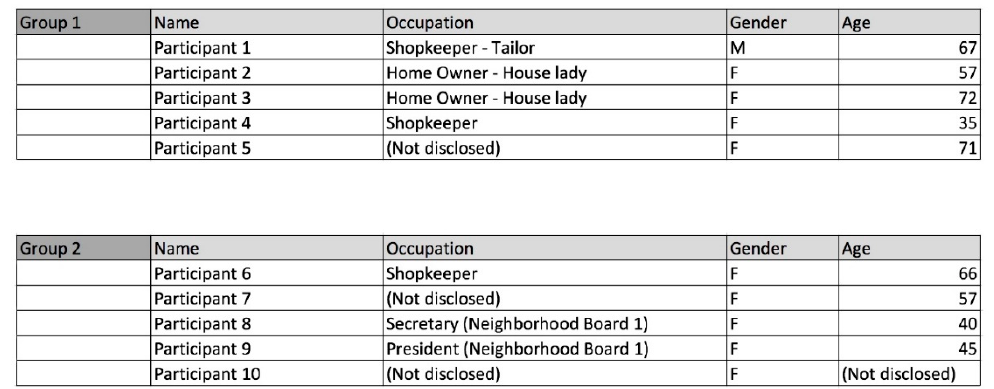
( b ) Figure 4. Results from tsunami simulations [46]. ( a ) Inundation heights. Thick black line represents the coastline, with thin lines showing contour lines at every 5 m ground elevation. ( b ) Tsunami waveform at the virtual gauge G (See Figure 3a). 3.3. Community Mapping The perception of the community regarding the potential risks, disaster preparedness and risk mitigation strategies was captured through a participatory community mapping exercise. This activity was conducted on 6 August 2017, and involved 10 individuals from different socioeconomic